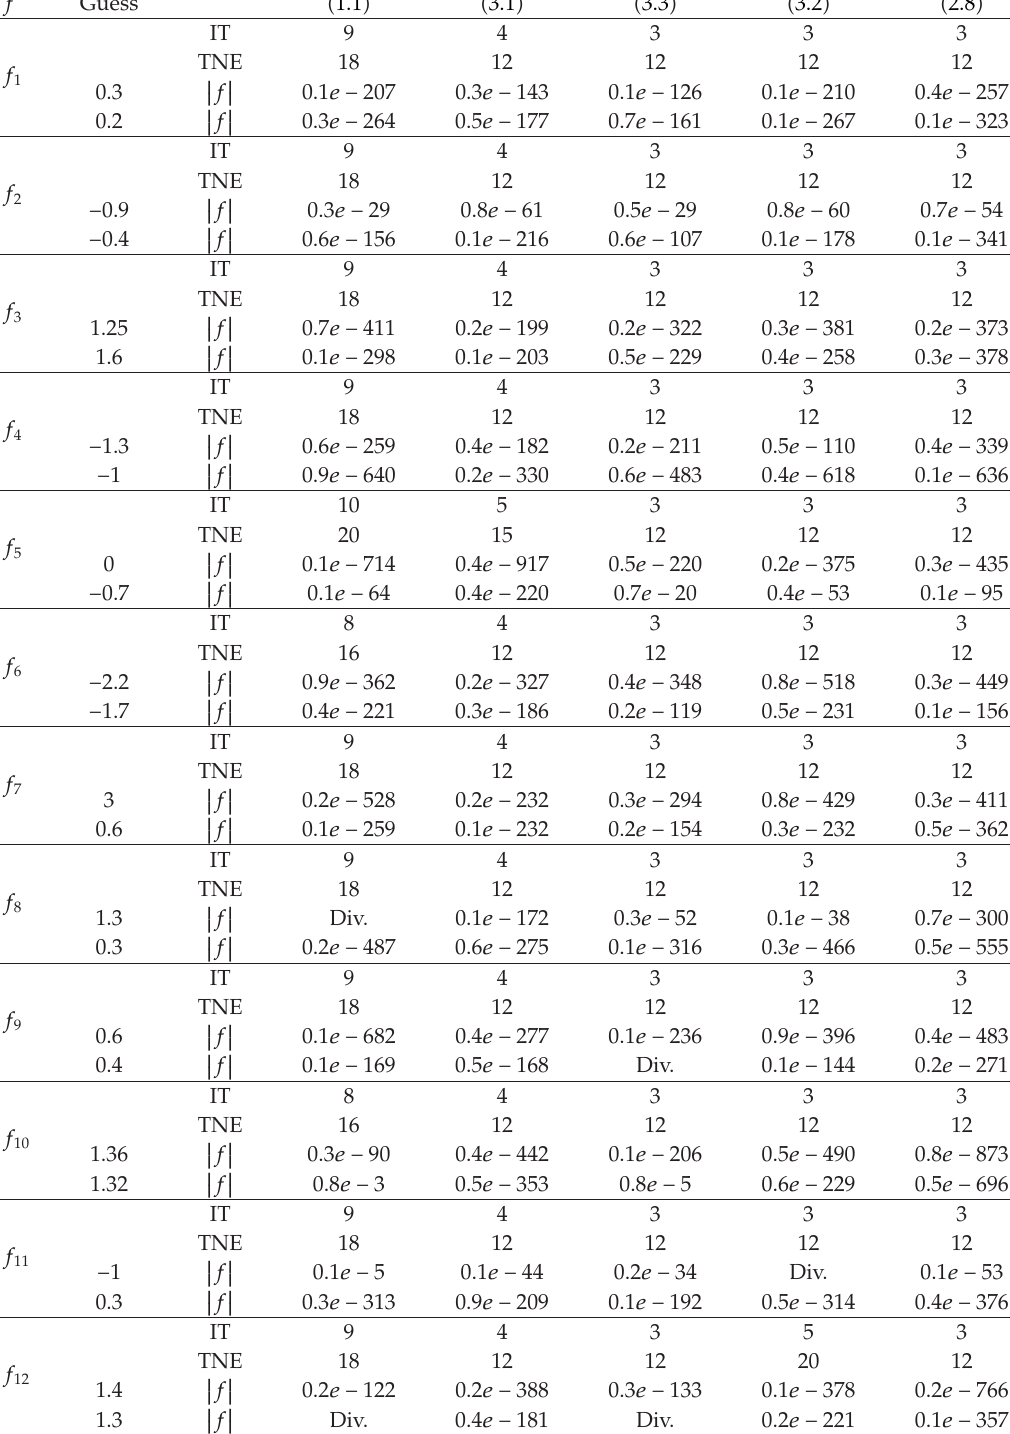
Table 2: Results of convergence for di ff erent derivative-free